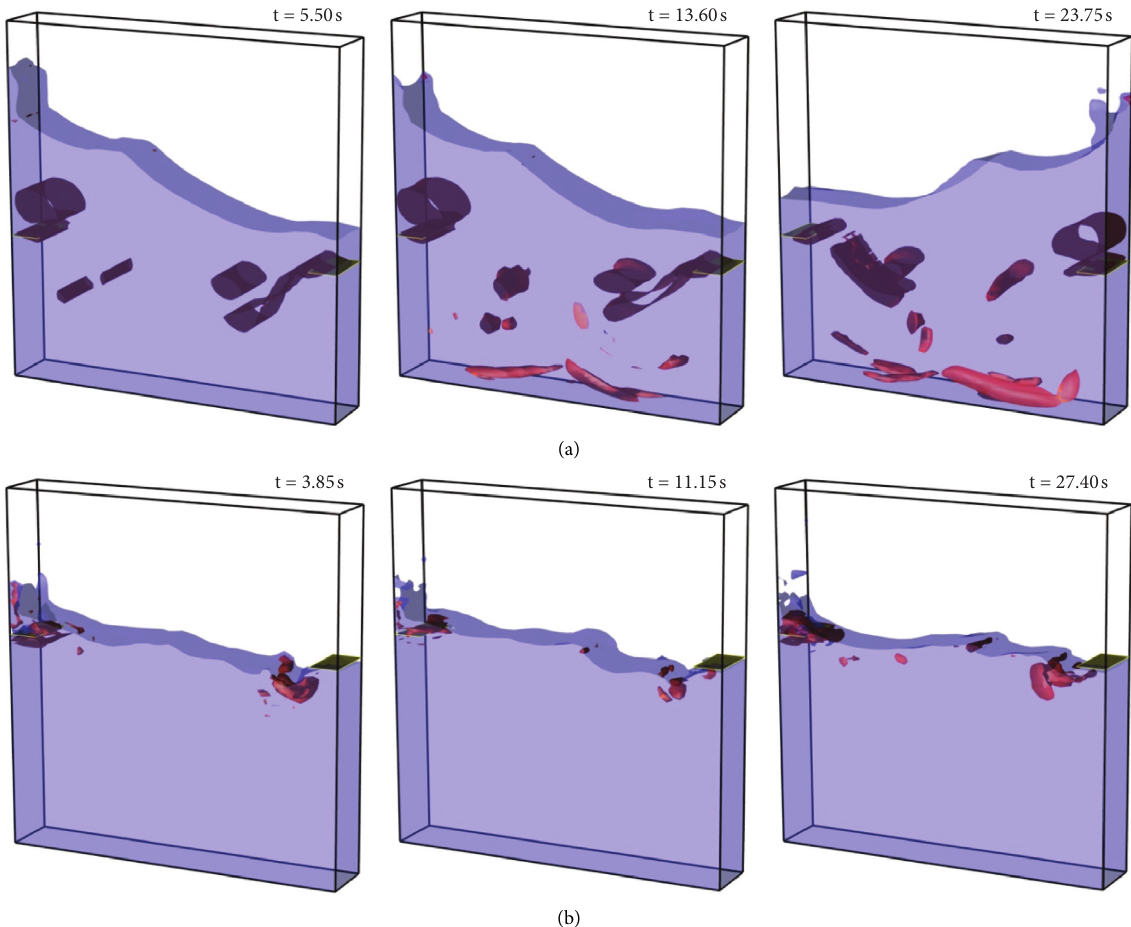
Figure 10: Free surface snapshots and the vortexes of coupled sloshing for various horizontal baffle heights: (a) Dh / h � 0.67 and (b) Dh / h � 1.0.